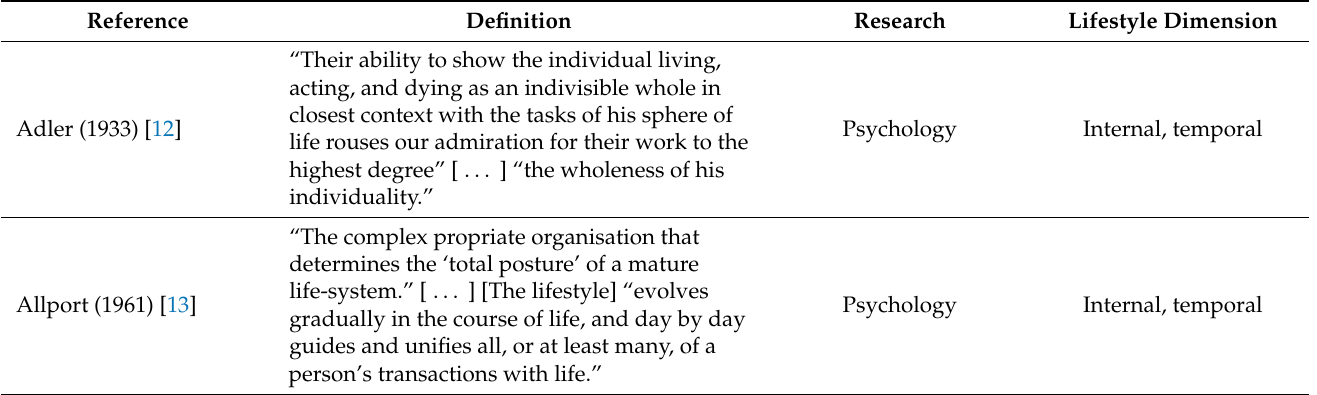
Table 1. Major explicit definitions of lifestyle in the psychological and sociological